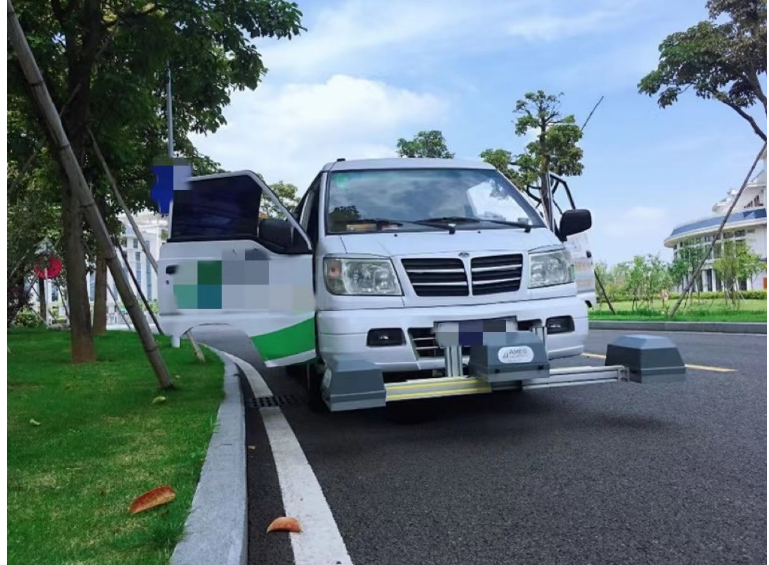
Figure 20. Road multi-function detection vehicle.